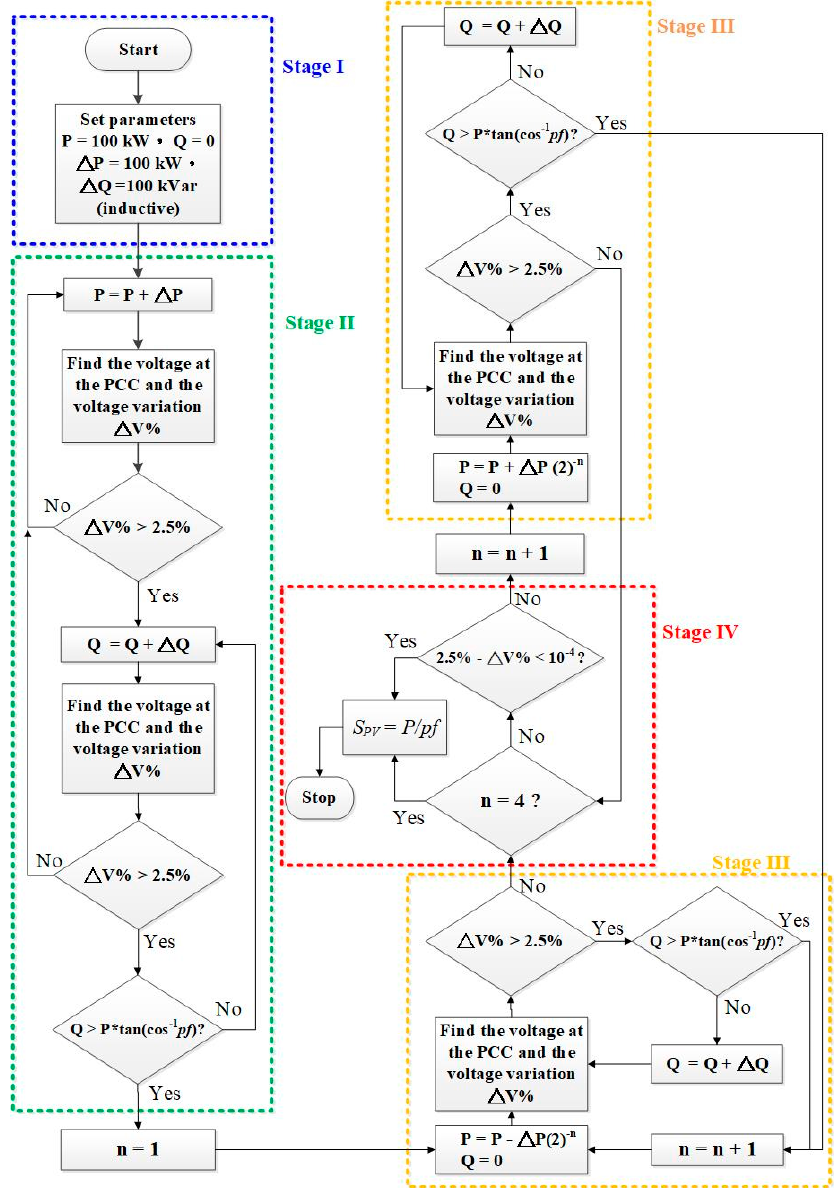
Figure 2. Flow chart to determine the maximum real power injection and capacity of a PV system with a smart inverter.